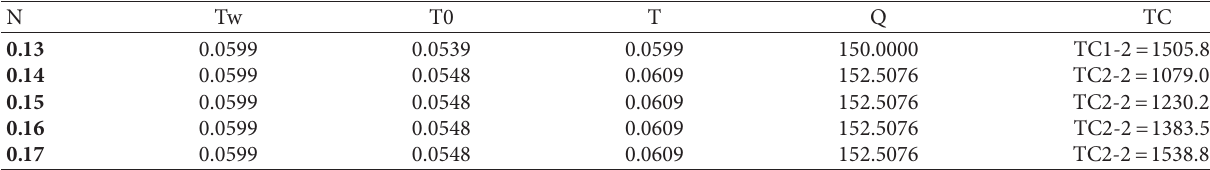
Table 4: The obtained solutions under different values of N.